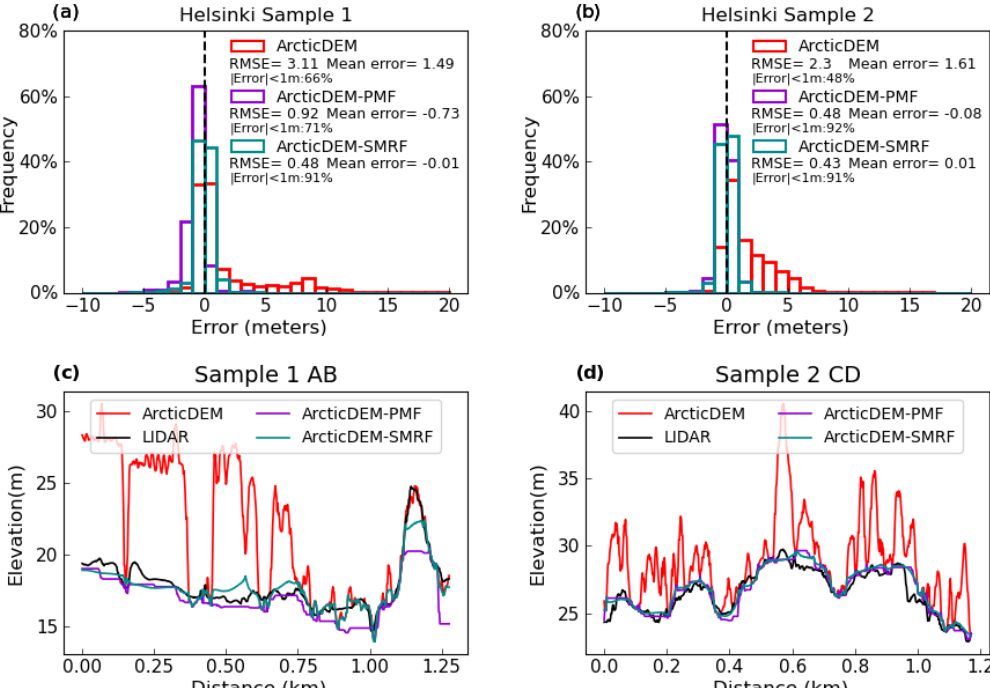
Figure 3. Error histograms of ArcticDEM, ArcticDEM with PMF applied (ArcticDEM-PMF) and ArcticDEM with SMRF applied (ArcticDEM-SMRF) for samples S1 (a) and S2 (b) . Profile of ArcticDEM, ArcticDEM-PMF, ArcticDEM-SMRF, and lidar DTM for tran- sects through S1 (c) and S2 (d) . The location of transects is shown in Fig. 1b and